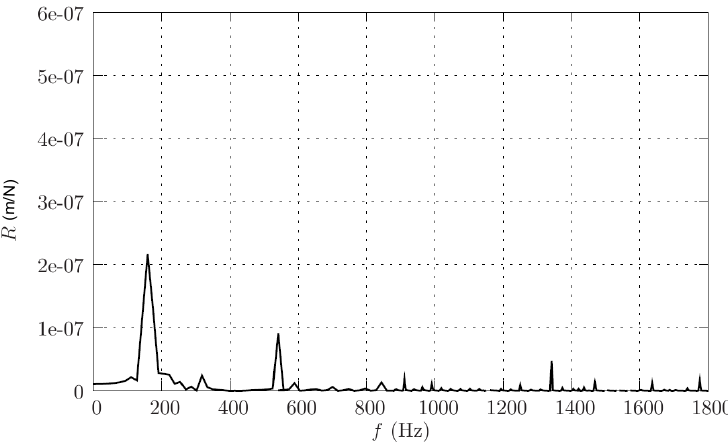
Figure 10. Receptance of the slab